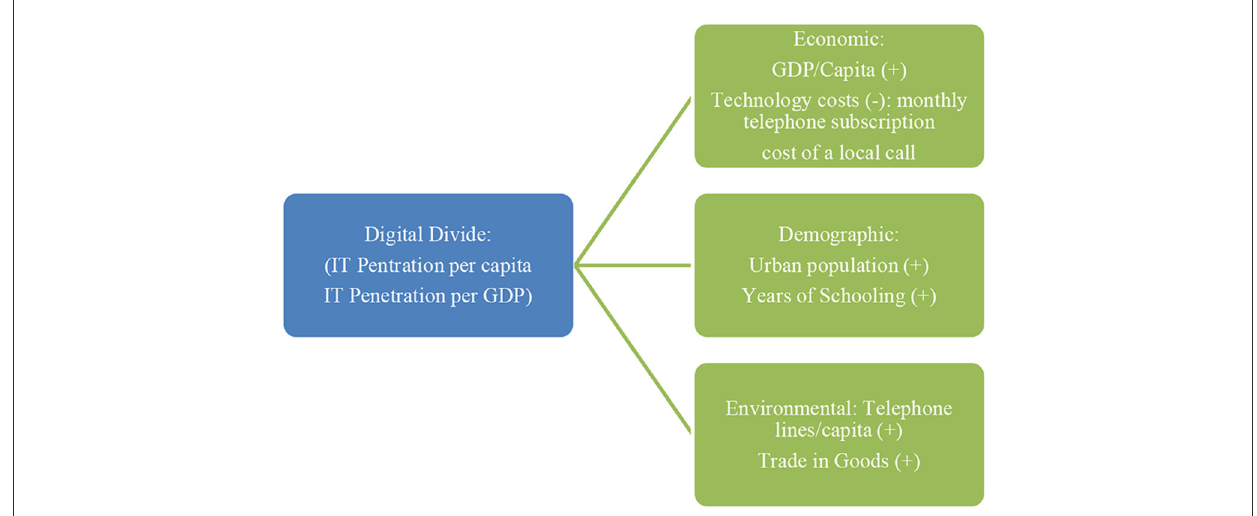
FIGURE1 An empirical framework for examining the digital divide. Source: Kraemer et al. (2005), p.